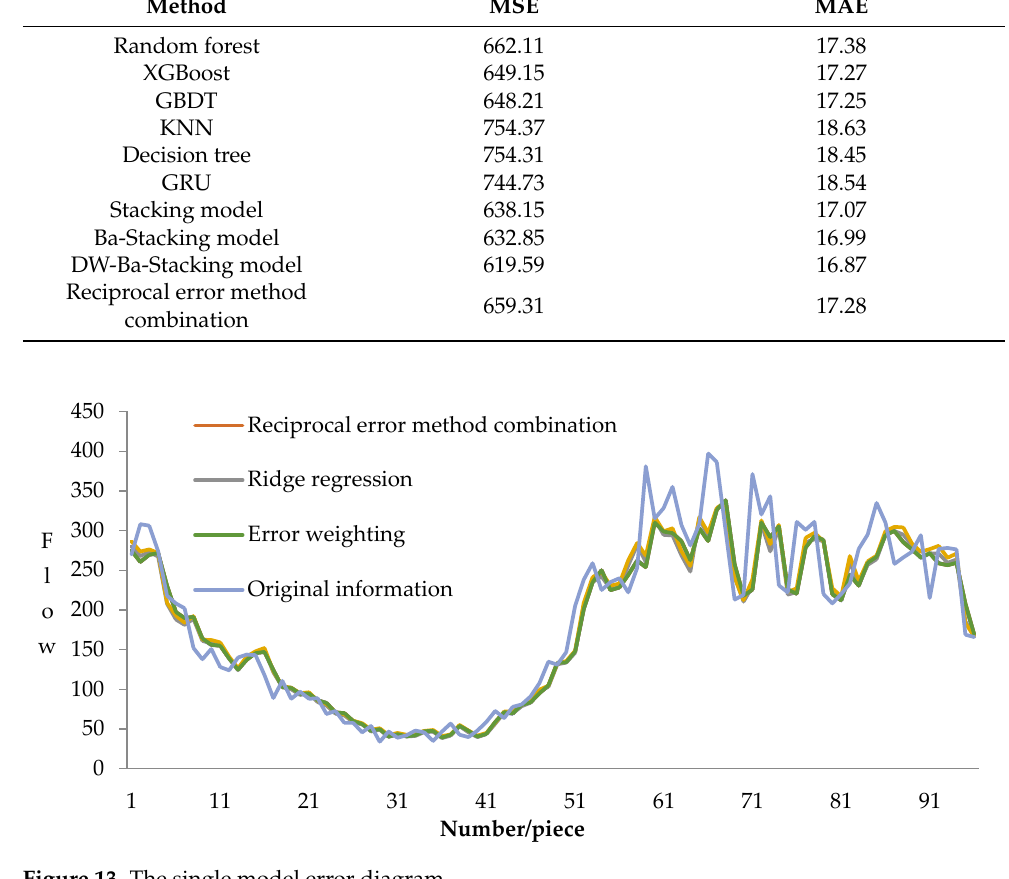
Table 6. A performance analysis of each combination model.